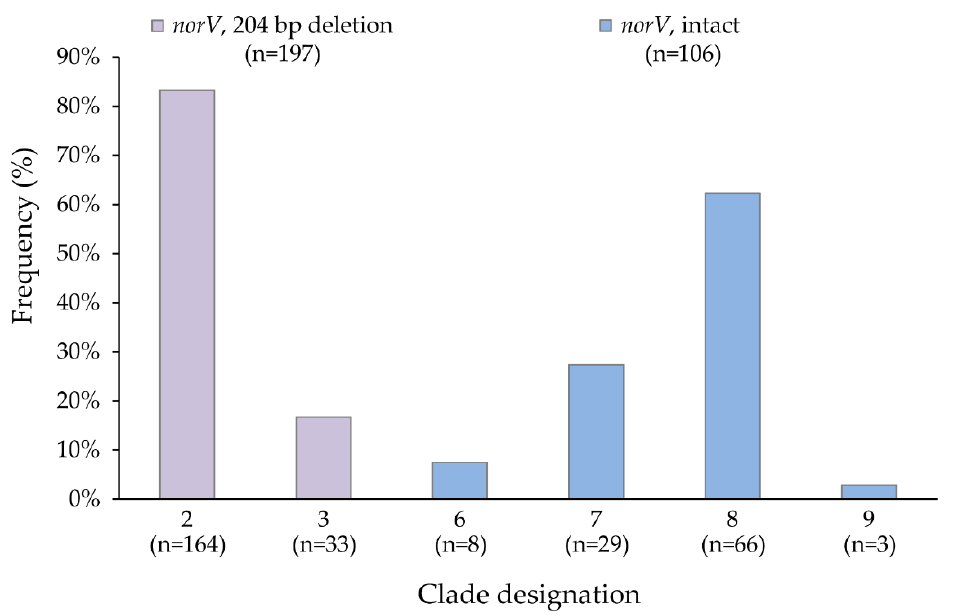
Figure 1. Distribution and percent of norV variants among 303 Shiga toxin-producing Escherichia coli O157 clinical isolates. Percentages for clades 2 and 3 were calculated using the total number of isolates with a deletion in norV ( n = 197, purple bars) as the denominator, whereas clades 6–9 used the total number with an intact norV ( n = 106, blue bars) as the denominator. Table 2. Distribution of stx profiles by clade and norV type among 303 Shiga toxin-producing Escherichia coli O157 clinical isolates.